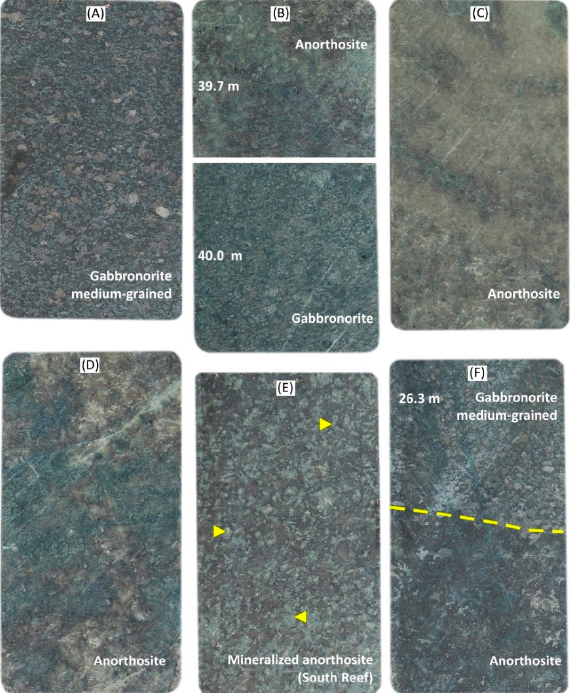
Figure 4. Different rock types from the Main Anorthosite Layer and its host rocks (Borehole 30). ( A ) Medium-grained gabbronorite from the footwall of the Main Anorthosite Layer (depth: 42.15–42.30 m). ( B ) Thirty centimeter-thick gradational lower contact of the Main Anorthosite Layer (depth: 39.7–40.0 m). ( C ) Monomineralic anorthosite (depth: 33.20–33.35 m). ( D ) Mottled anorthosite (depth: 29.45–29.6 m). ( E ) Mineralized anorthosite from the “South Reef”. The sample contains 2 ppm Au, 3 ppm Pt, and 33 ppm Pd, respectively. Note the replacement of interstitial minerals by secondary epidote and sulfides (depth: 27.75–27.90 m). ( F ) Sharp upper contact (dashed line) between anorthosite and the overlying medium-grained gabbronorite (depth: 26.30–26.45 m).